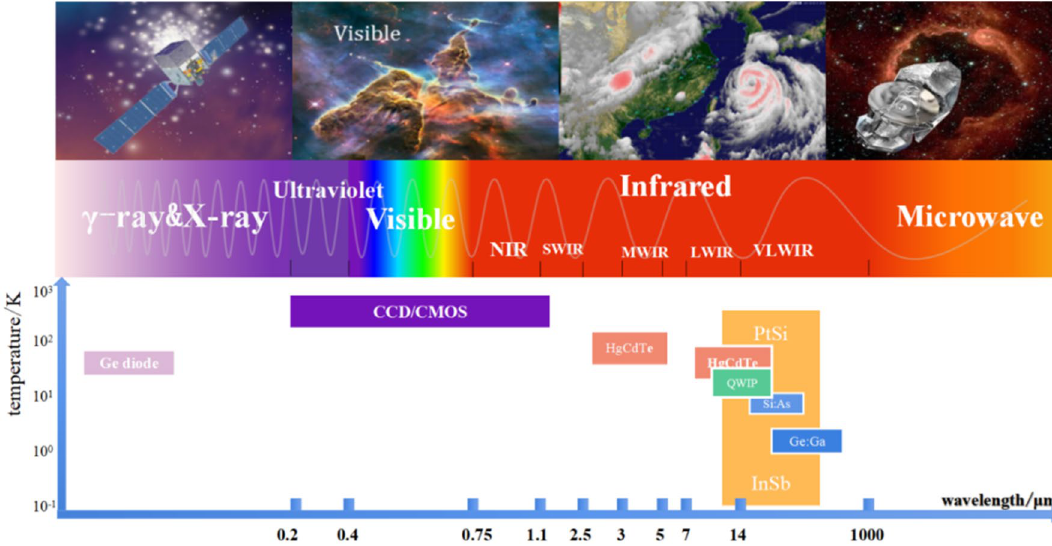
Figure 1. Working temperature maps of various detection wavelengths (generated by wps office, 11.1.0.11115-releaase, https:// www. wps.